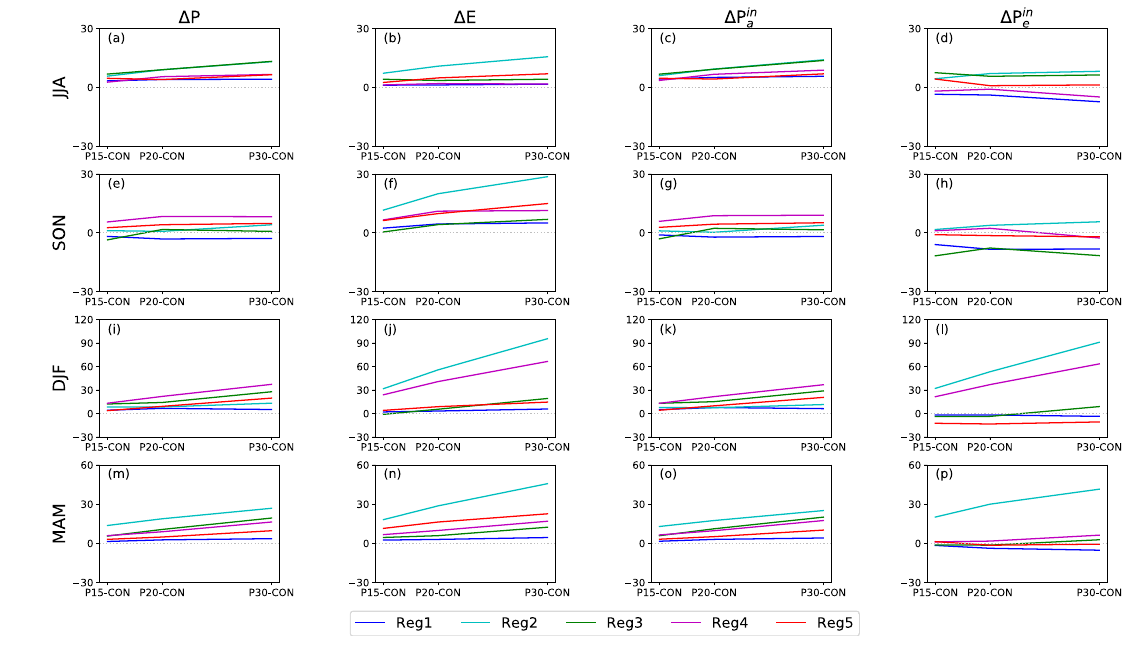
Figure 10. For all five regions, percentage differences (mm day − 1 ) in seasonal-mean ( a ) precipitation ( ∆ P ), ( b ) evaporation ( ∆ E ), ( c ) precipitation contribution from remote sources ( ∆ P in a ) and ( d ) precipi- tation contribution from local recycling ( ∆ P in e ) for P15 and CON, P20 and CON, P30 and CON for JJA season, normalised by the CON values. Other seasons shown are SON ( e – h ), DJF ( i – l ) and MAM ( m – p ). The grey horizontal dotted line demarcates zero.